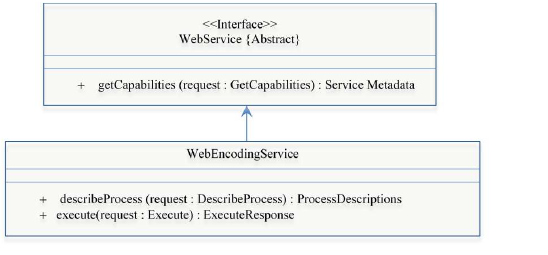
Figure 4. The WES Interface based on